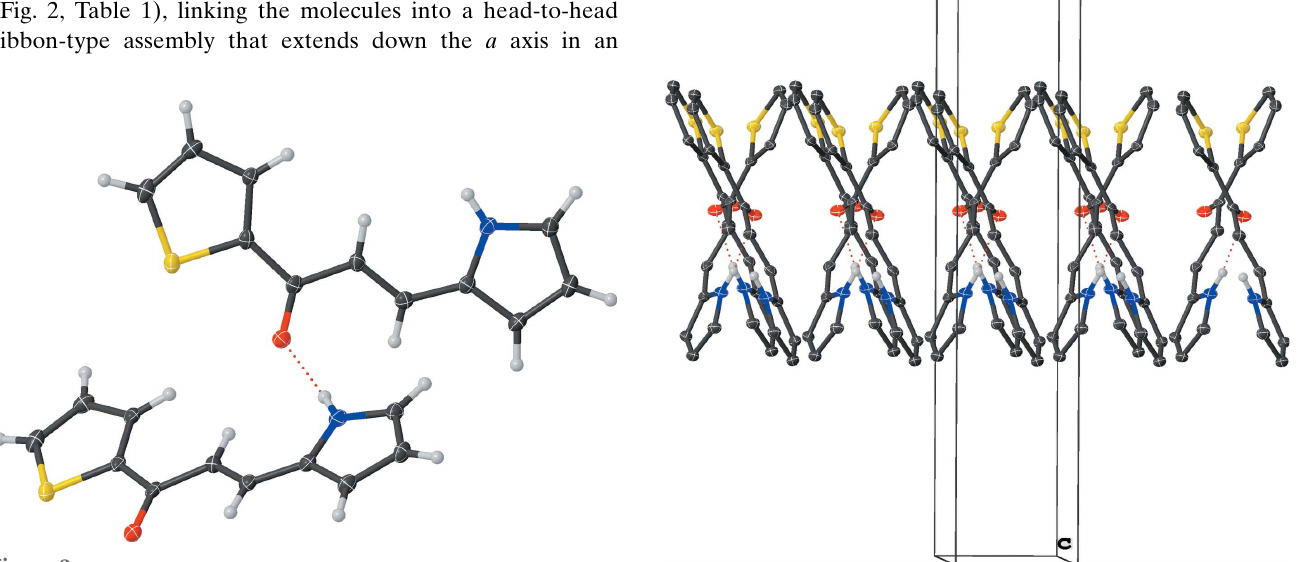
Figure 2 The hydrogen bonding (dashed line) between the amine group and the carbonyl oxygen atom (Table 1). Displacement ellipsoids are drawn at the 50% probability level.